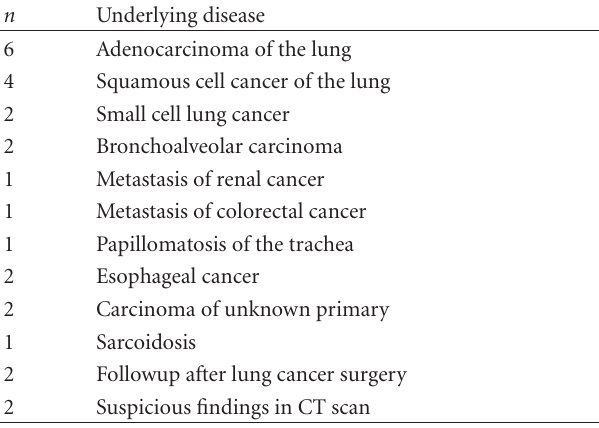
Table 1: Underlying diseases which were indications for bron-